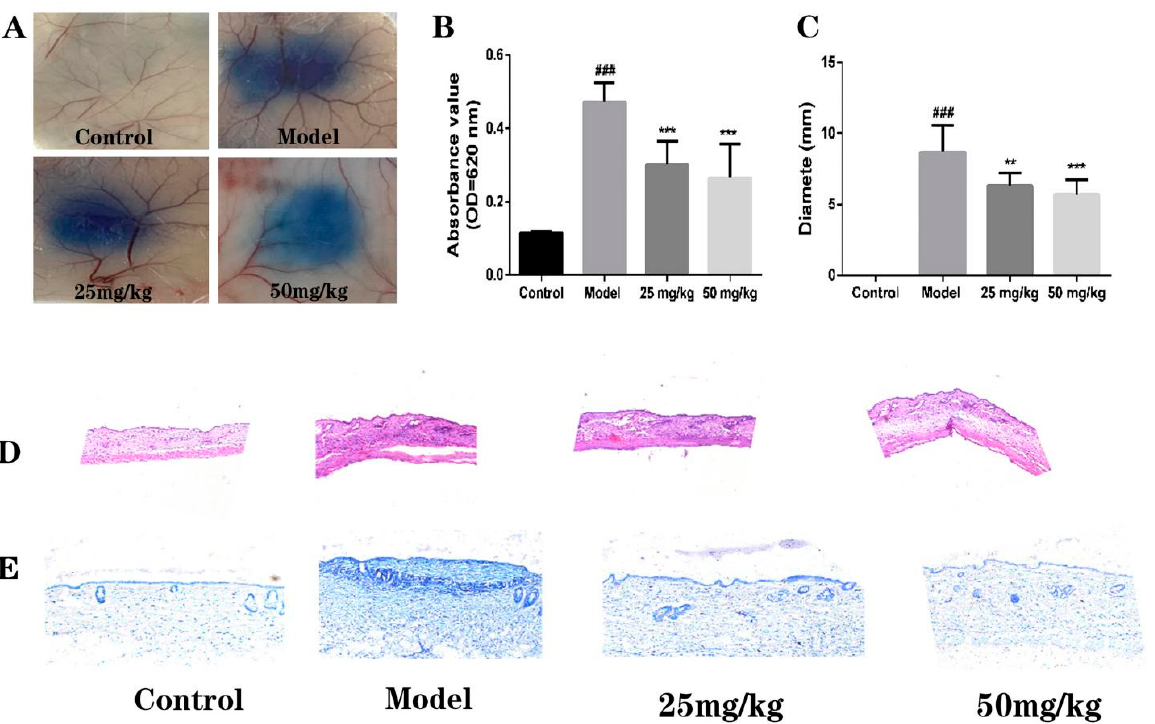
Figure 6. Effect of AT on C48/80-induced local cutaneous inflammation in PCA. ( A ). Representative images showing Evans Blue dye extravasation; ( B ). Evans Blue extravasation in the back skin; ( C ). Evans Blue content and diameter of back. ( D , E ). The pathological analysis of C48/80-induced skin response with AT treatment, including the effect of AT on eosinophil recruitment, MC degranulation. The data are presented as the mean ± S.D. ** p < 0.01, *** p < 0.001 versus the model group. ### p < 0.001 versus the control group, n = 6.